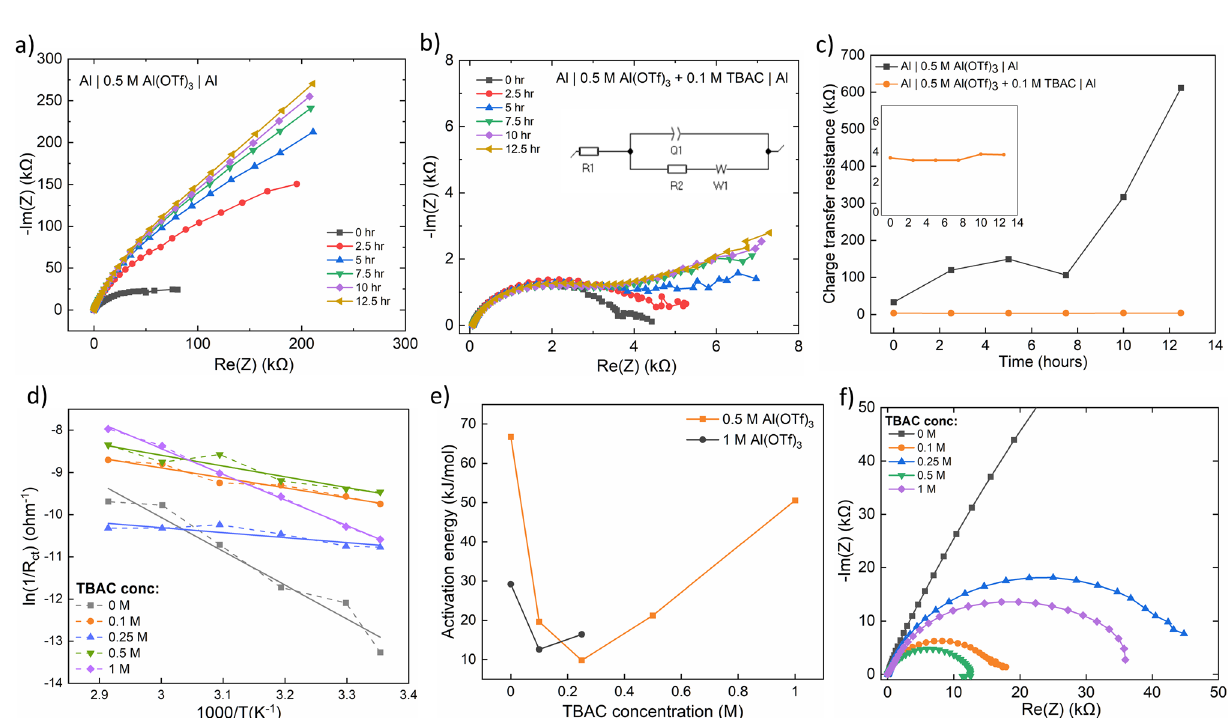
Fig. 2 Nyquist plot collected at 2.5 h of intervals after cell fabrication for: a Al | 0.5 M Al(OTf) 3 | Al symmetric cells, b Al | 0.5 M Al(OTf) 3 + 0.1 M TBAC | Al symmetric cells (inset: circuit used for fitting a and b). c Charge transfer resistance as a function of time, gener- ated after fitting impedance data in Fig. 2a, b (inset: zoomed in data for TBAC cell). d Logarithmic plot of inverse of charge transfer resistance (obtained after fitting respective data in Fig. S4) versus the inverse of the temperature. Each plot, which is also linearly fitted with the solid lines, is for Al | 0.5 M Al(OTf) 3 + x M TBAC | Al symmetric cell with varying concentration ( x ) of TBAC. e Surface activation energy as a function of TBAC concentration (calculated from Figs. 2d and S5d for 0.5 and 1 M Al(OTf) 3 electrolyte, respectively). f Nyquist plot collected for Al | 0.5 M Al(OTf) 3 + x M TBAC | Al symmetric cells with varying concentration ( x ) of